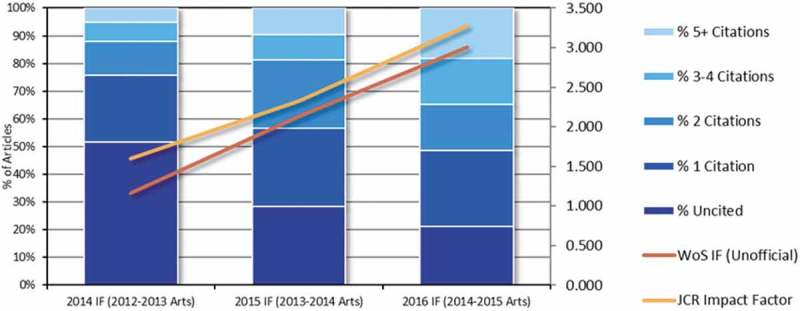
Article citations.